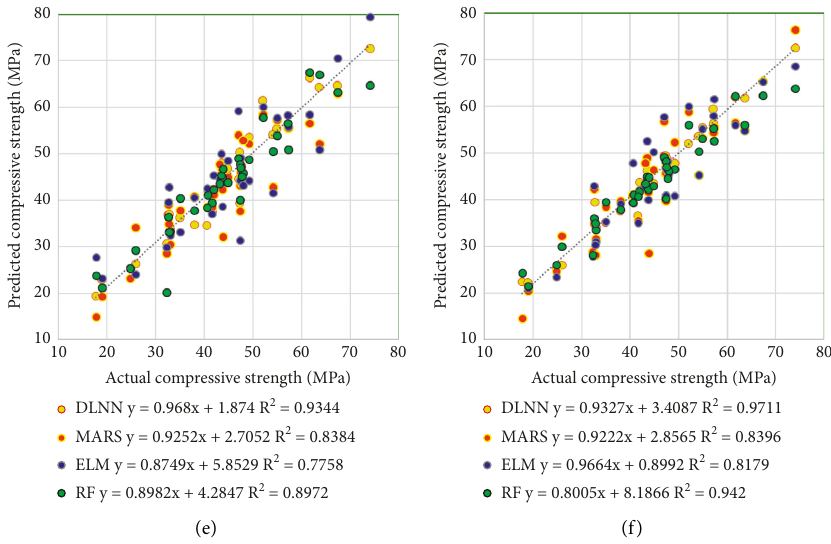
Figure 13: Scatter plot diagram for the developed AI models using all input combinations. (a) Model I. (b) Model II. (c) Model III. (d) Model IV. (e) Model V. (f) Model VI.